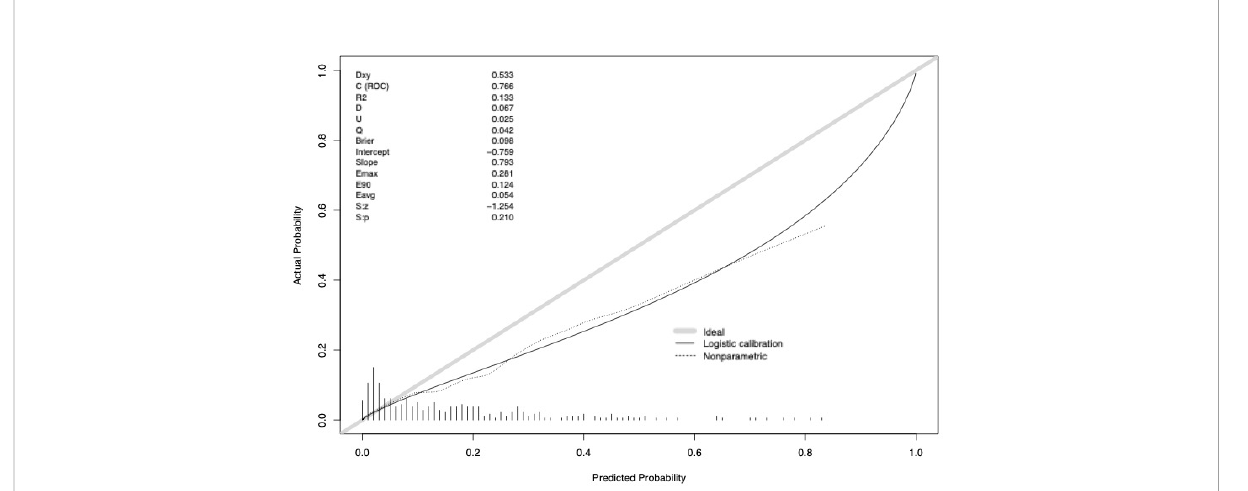
FIGURE 2 Decision curve analysis depicting the net bene fi t of the Nocera nomogram in the external validation cohort (dotted red line), relative to treat none (black line) or treat all (gray line). The nomogram shows a greater net bene fi t until a threshold probability of